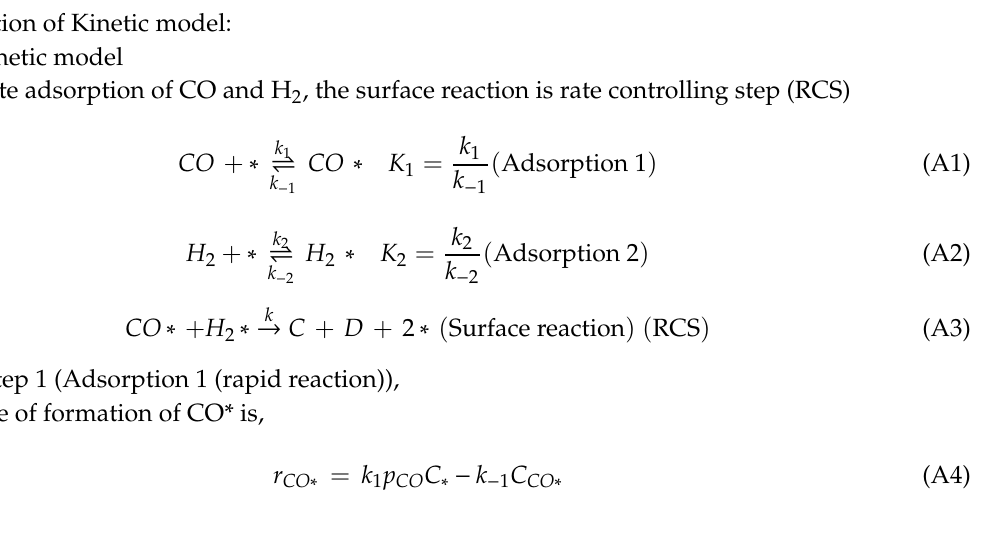
Figure S1: title, Table S1: